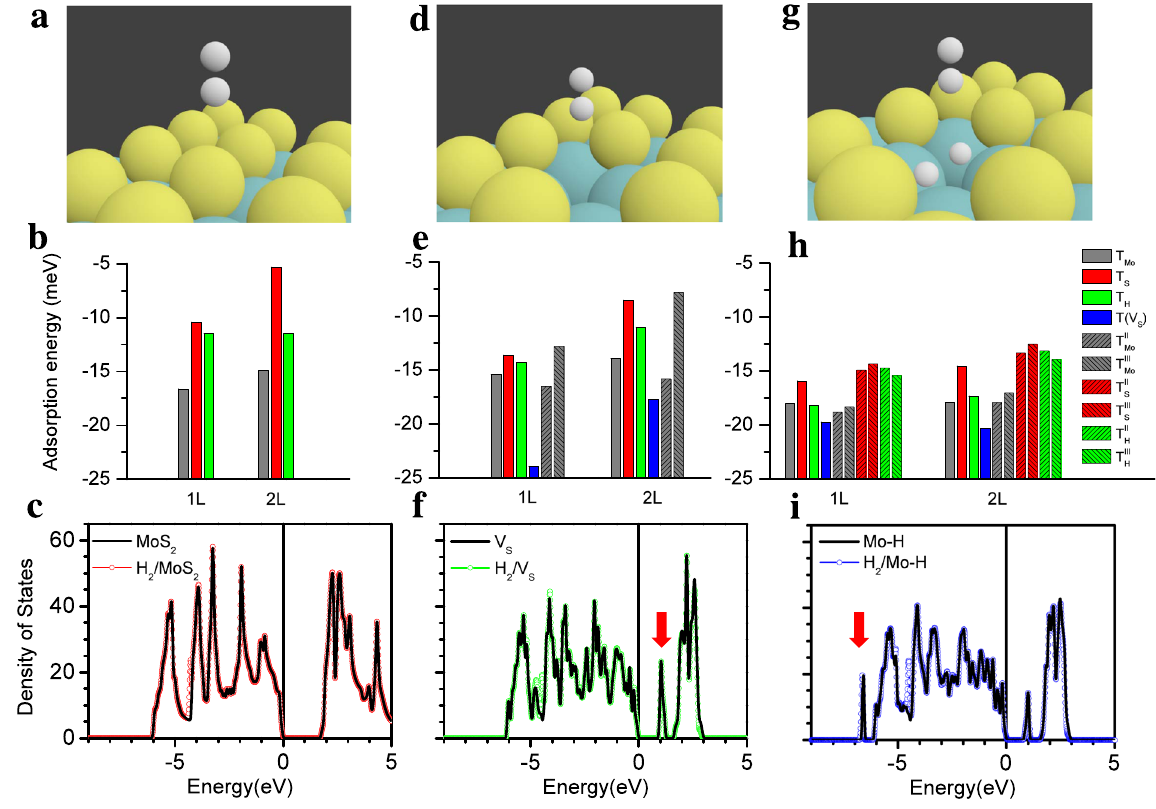
Figure 1. Enhancement of the hydrogen physisorption via the creation of a sulphur vacancy on the MoS 2 basal plane. (Upper panels) Schematic of a H 2 molecule adsorption on each surface with no defect ( a – c ), one S-vacancy ( d–f ) and two absorbed H atoms on the Mo atoms around the S-vacancy ( g–i ). Small (white), middle (yellow) and large (azure) balls indicate the H 2 molecule, S and Mo atoms, respectively. (Middle panels) Comparison of the adsorption energies of H 2 molecule on top of the Mo, S and hollow sites for mono- (left) and bilayer (right) MoS 2 surfaces, respectively. (Bottom panels) Comparison of the total density of states with and without the H 2 molecule adsorption. The vertical solid lines in each panel indicate the VBM being set to zero in order to clarify the